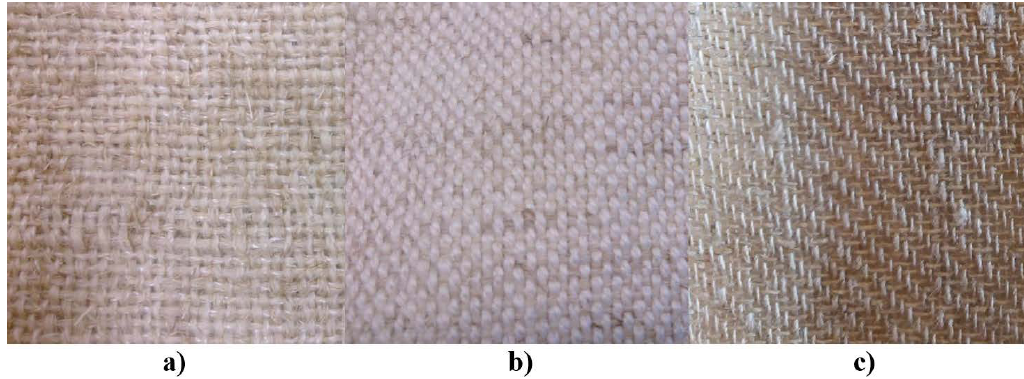
Figure 1: Natural fibre fabric: (a) Banana (b) Banana with cotton (c)